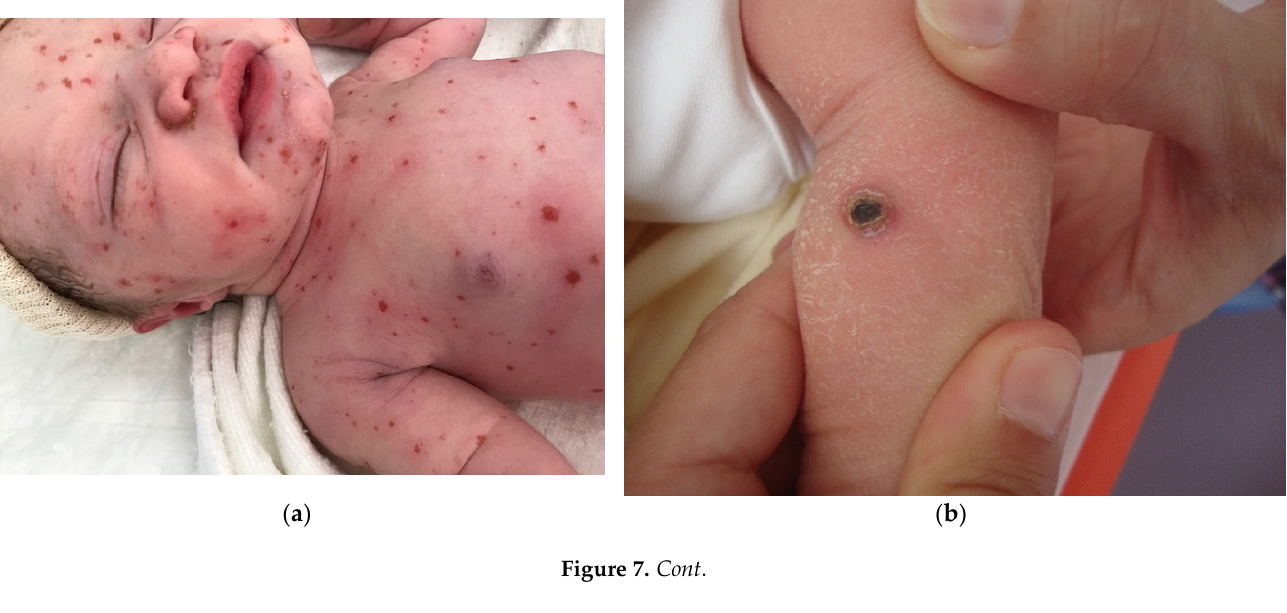
Figure 6. 40× Rhaboid tumor. Very atypical large cells. Figure 6. 40 × Rhaboid tumor. Very atypical large cells. Outcome